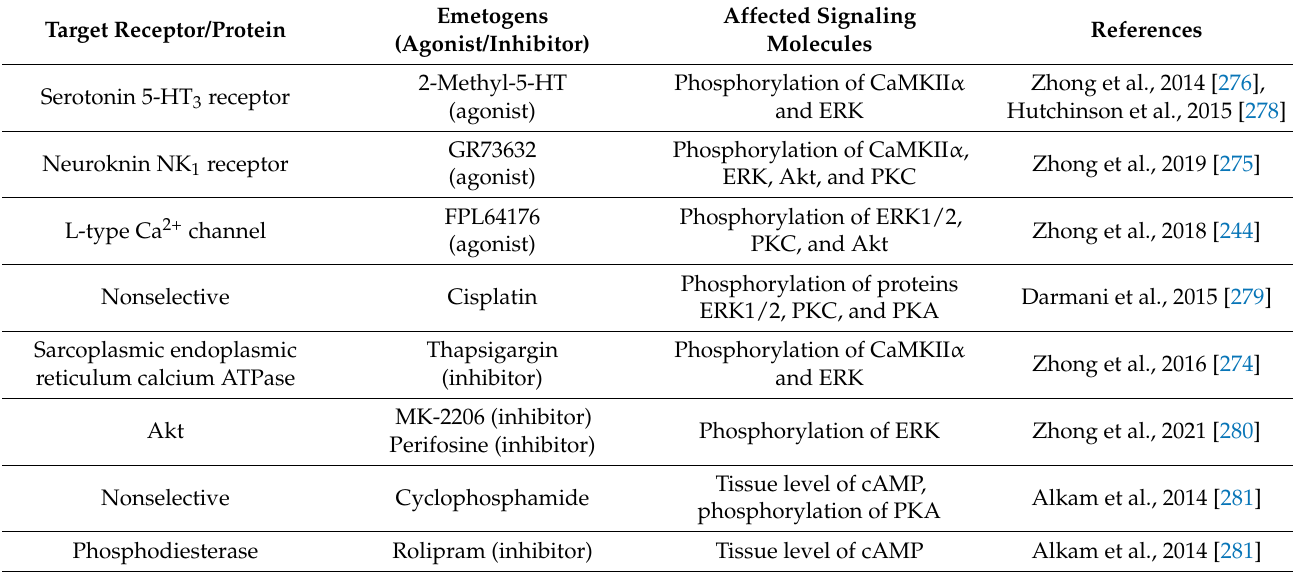
Table 1. Intracellular signaling molecules affected by vomiting-evoked by diverse emetogens in the least shrew vom- iting model. The emetics include selective receptor agonists and nonselective chemotherapeutics, e.g., cisplatin and